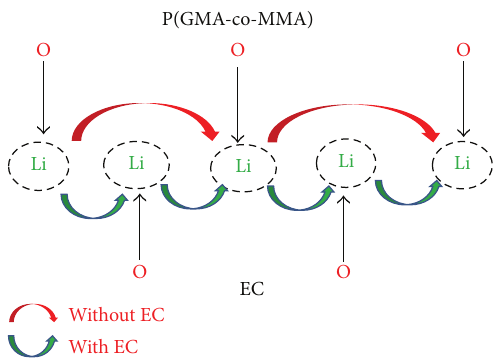
Figure 4: Possible conductivity mechanism of polymer based polymer electrolyte with EC.